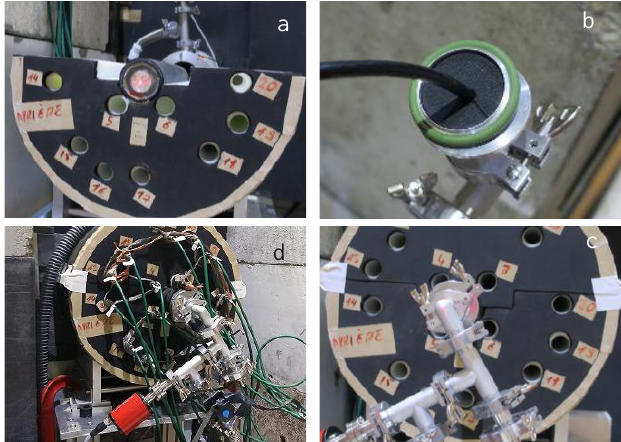
Fig. 2. Photographs of LOENIEv2 during the installation: when aligning the system with the neutron beam (a); placing the beam stop at the end of the airtight tube (b), installation of the target chamber inside the detection setup (c); after connecting all the detectors (d).